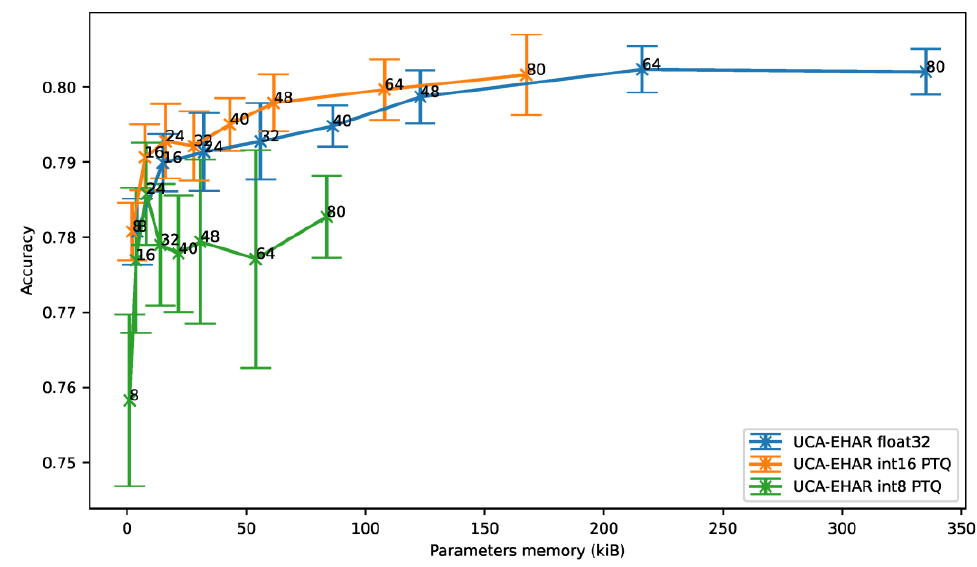
Figure 6. Accuracy vs. parameters memory. The confusion matrix, shown in Figure 7 and extracted from one training for 80 filters per convolution, highlights the difficulty for an artificial neural network to differentiate the SITTING and STANDING activities from the collected data. The reason is that the orientation of the smart glasses remains the same for both classes, and the signals mostly stay constant for both of these motionless activities as seen in Figures A3 and A4 of Appendix C. It can be noted that the same confusion was already observed on existing datasets such as UCI-HAR.